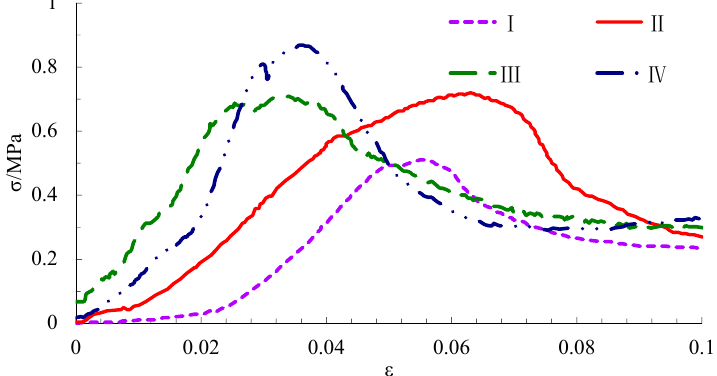
Figure 8. Stress-strain curves of the four types of specimens after a curing time of 24 h.